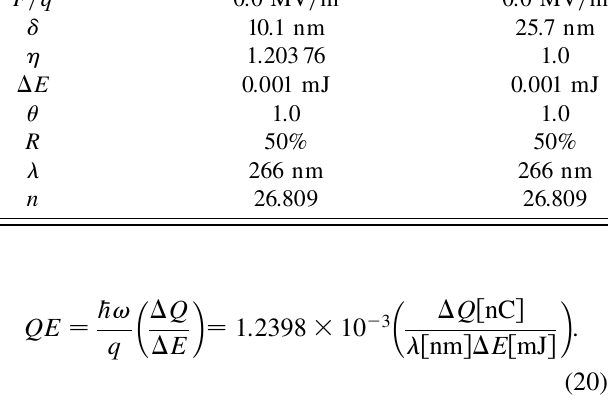
Symbol Tungsten